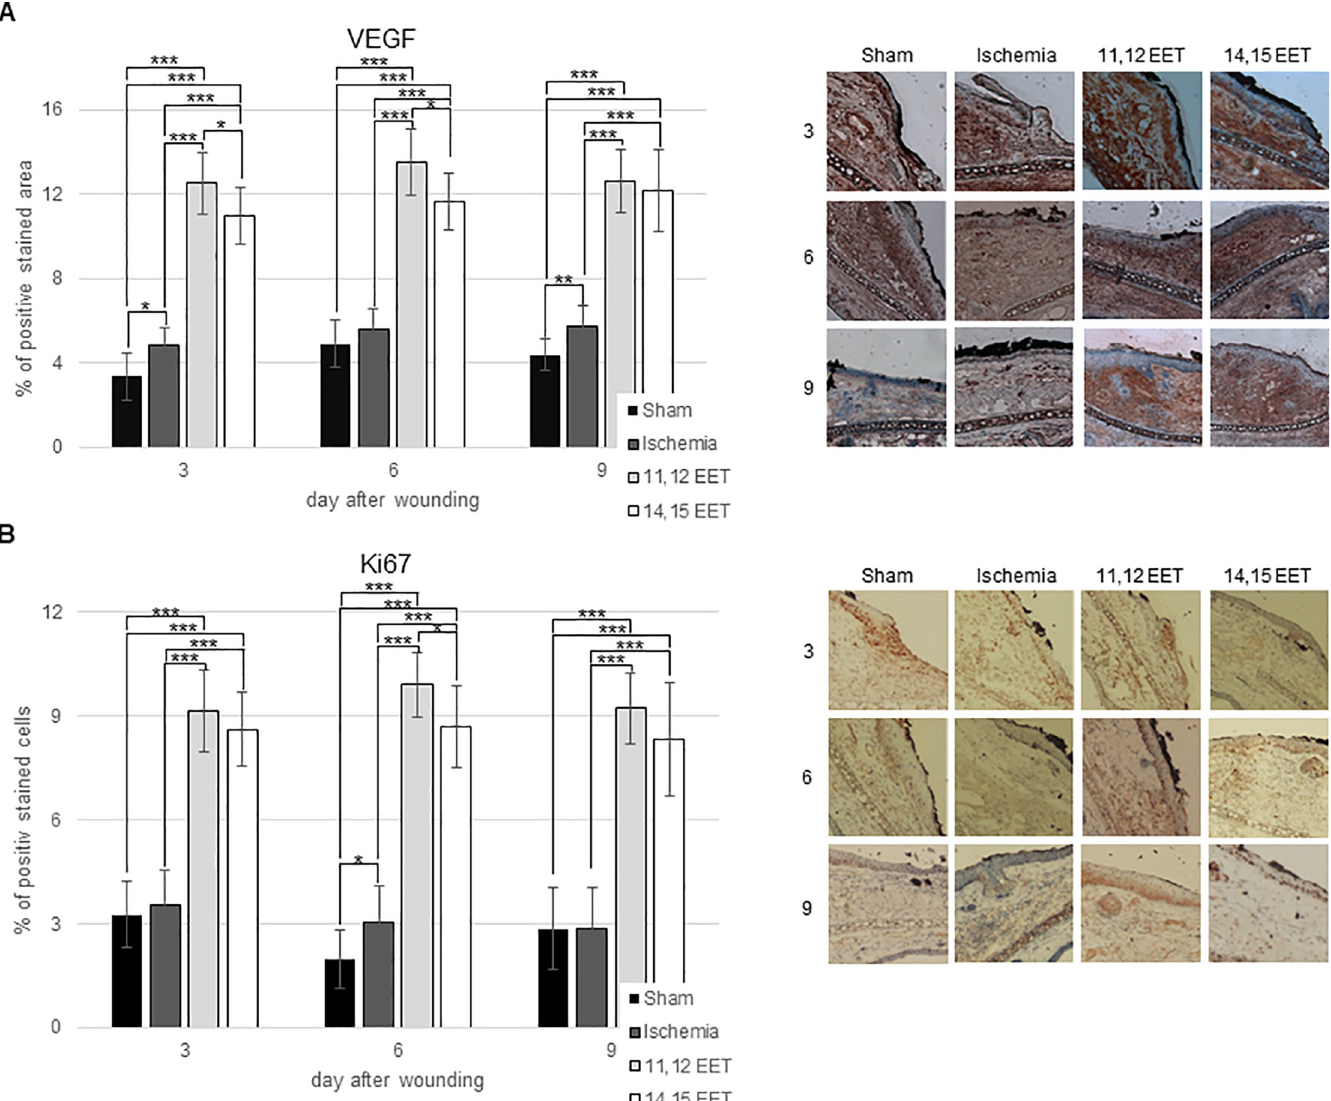
Fig 3. A Percentage of VEGF positive area on day 3, 6, and 9 after wounding ofcontrol, ischemic and 11,12 as well as 14,15 EET treated ischemic wounds. On the right representative pictures of immunohistological staining. B Percentage of Ki67 positive cells on day 3, 6 and 9 after wounding ofcontrol, ischemic and 11,12 as well as 14,15 EET treated ischemic wounds. On the right representative pictures of immunohistological staining (data is shown as mean ± SD; n = 8 ). � p < 0.05, ��� p < 0.001.